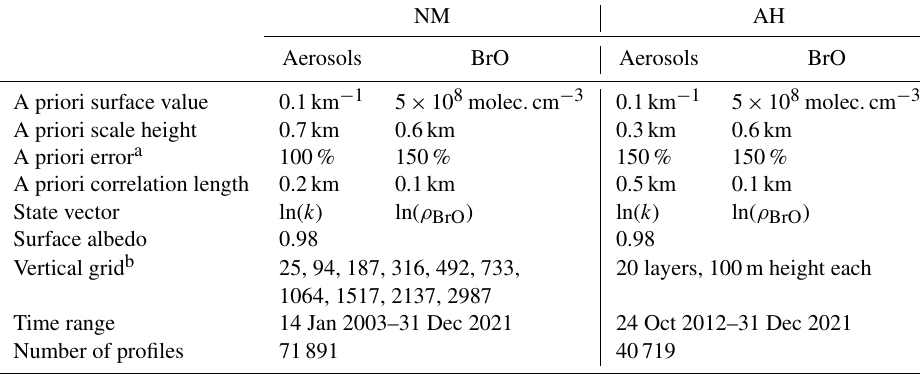
Table 3. The main settings of aerosol and BrO vertical profile retrievals.